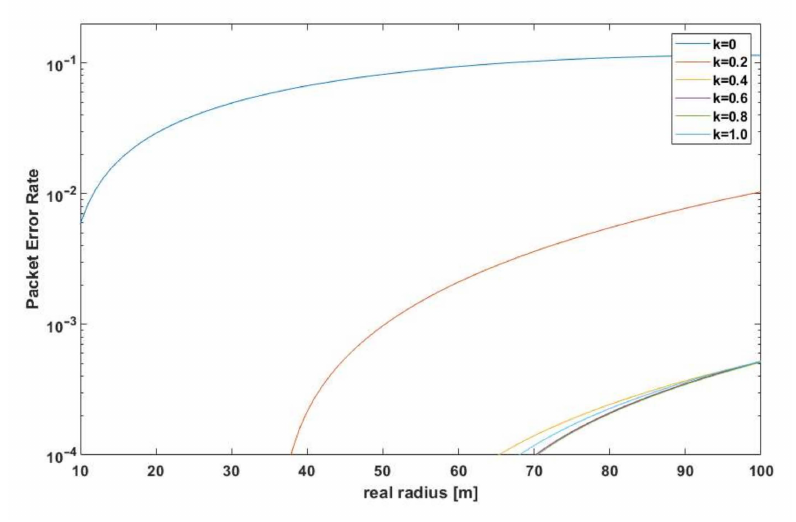
Figure 11. PER values for different k -factor